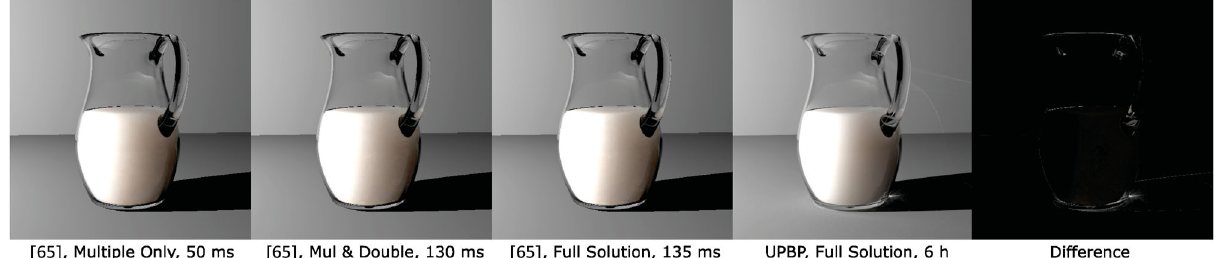
Fig. 19 Results from Ge et al. [65] and UPBP. Reproduced with permission from Ref. [65], c (cid:2) IEEE